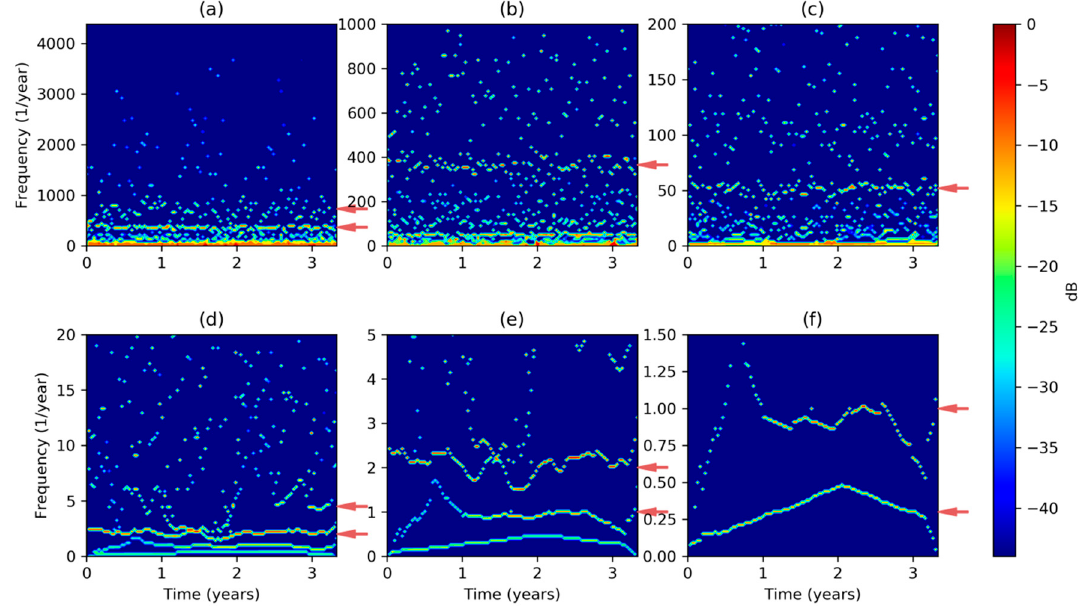
Figure 12. Electricity demand Discrete Hilbert–Huang Transform at different frequency scales: ( a ) Very high; ( b ) high; ( c ) medium high; ( d ) medium low; ( e ) low; ( f ) very low.